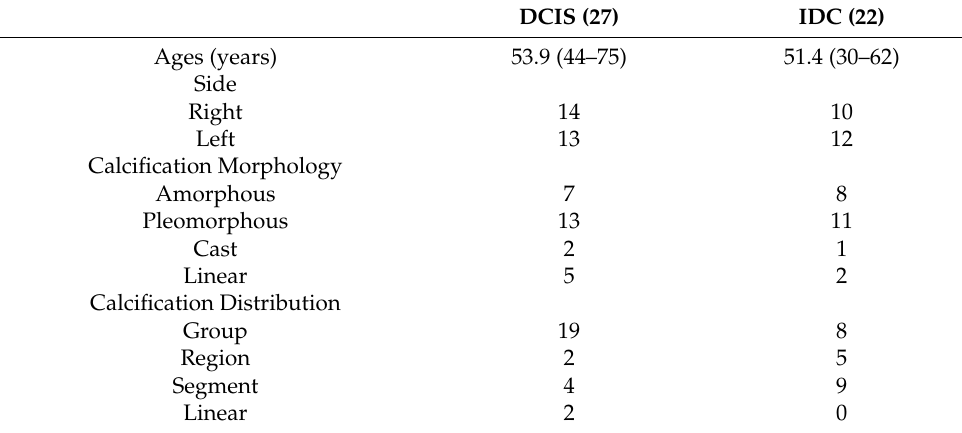
Table 1. Characteristics of patients and microcalcifications.